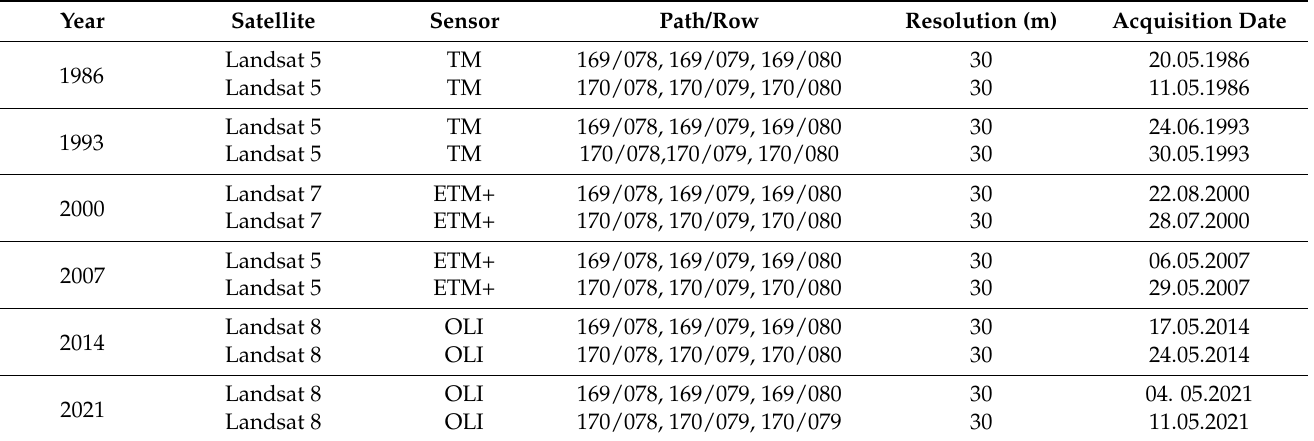
Table 2. The Landsat satellite images used in the